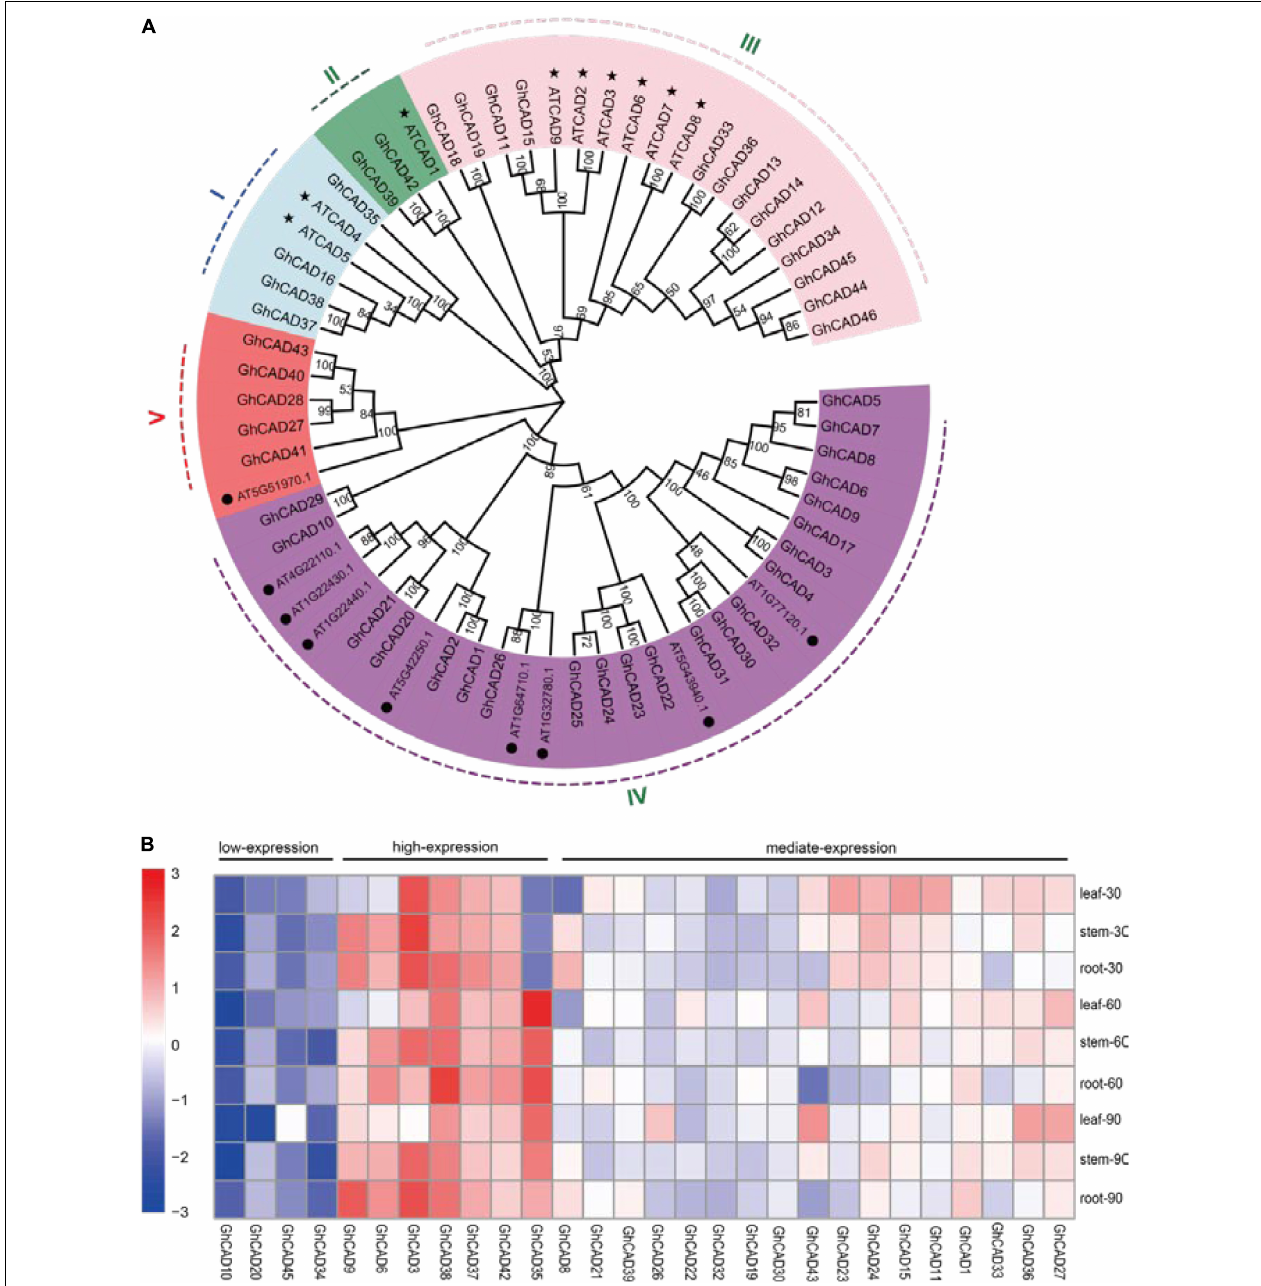
FIGURE 1 | The phylogenetic analysis and tempo-spatial expression pattern of the CAD genes in G. hirsutum . (A) Phylogenetic tree of CAD proteins from Arabidopsis and G. hirsutum . The phylogenetic tree was generated by the Neighbor-Joining (NJ) method with 1,000 bootstrap replicates. CAD proteins were divided into I-V groups distinguished by different colors. The nine bona fide CADs of Arabidopsis were marked by “ this study were marked by “ (cid:72) .” (B) The tempo-spatial expression pattern of 28 GhCAD genes. The expression of different GhCADs in the leaf, stem, and root tissues of 30-, 60-, 90-day old plants, respectively. Three biological replicates were performed for each treatment. The expression of GhCAD s was relative to that of GhUBQ7 .